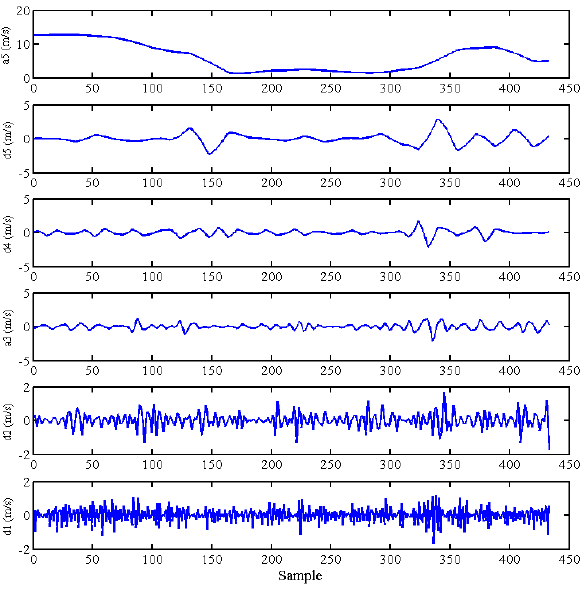
Figure 6. An example of wind speed decomposition using wavelet decomposition.